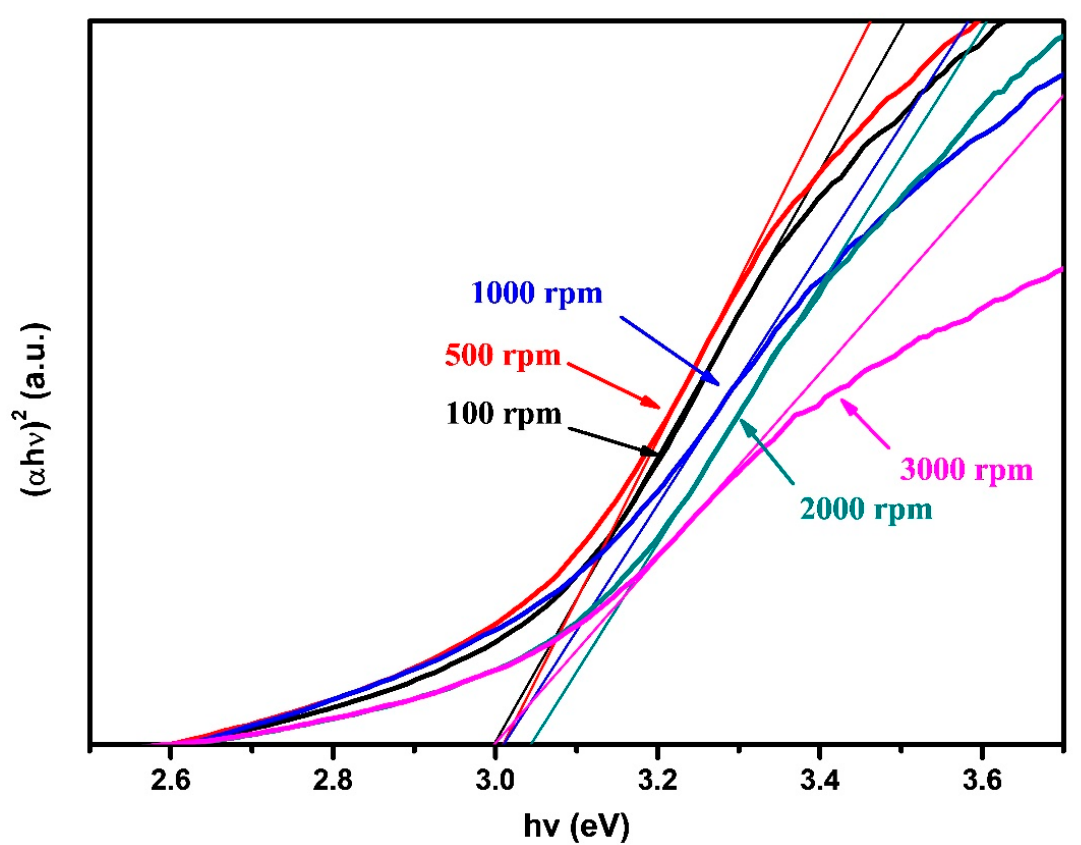
Figure 12 indicates the resistivity measured by the system of the two-point probe. The resistivity of CuCrO 2 thin films produced at different speeds of rotation and vacuum- recovered at 600 ◦ C for 10 min is shown in Table 3. The values of parallel resistivity were 6.79 × 10 7 (100 rpm), 2.12 × 10 7 (500 rpm), 1.68 × 10 6 (1000 rpm), 4.21 × 10 6 (2000 rpm), and 1.88 × 10 5 (3000 rpm), respectively. Those of vertical resistivity were 4.88 × 10 7 (100 rpm), 1.05 × 10 6 (500 rpm), 7.73 × 10 6 (1000 rpm), 2.67 × 10 9 (2000 rpm), and 6.03 × 10 7 (3000 rpm), respectively. The anisotropic CuCrO 2 thin film conductivities in the parallel and vertical directions differed by nearly two to three orders of magnitude.